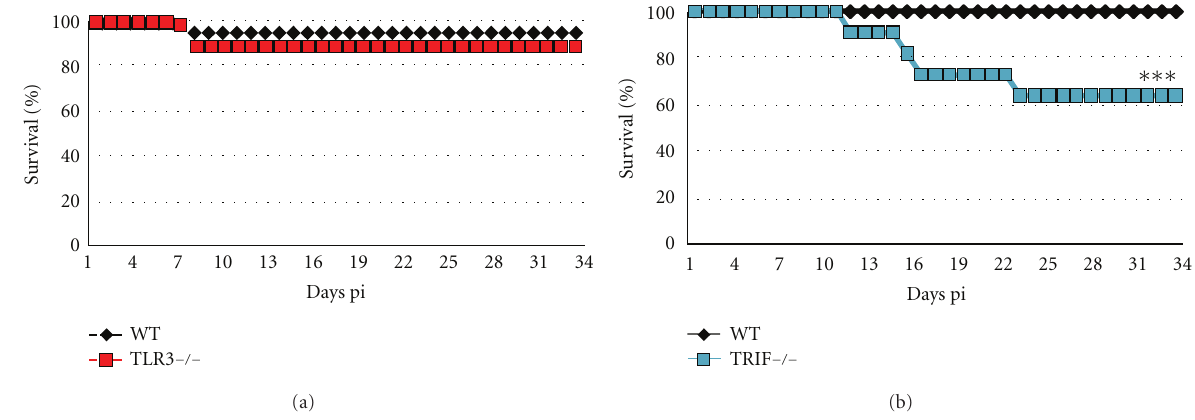
Figure 2: Survival di ff ers between TLR3-deficient (TLR3 − / − ) and TRIF − / − mice with CVB3 myocarditis/DCM. (a) Survival of TLR3 − / − mice compared to WT B6.129 controls (TLR3 − / − versus WT, n = 77/group). (b) Survival of TRIF − / − mice compared to WT BL/6 controls (TRIF − / − versus WT, n = 45 / group), ∗∗∗ : P < 0 . 001.